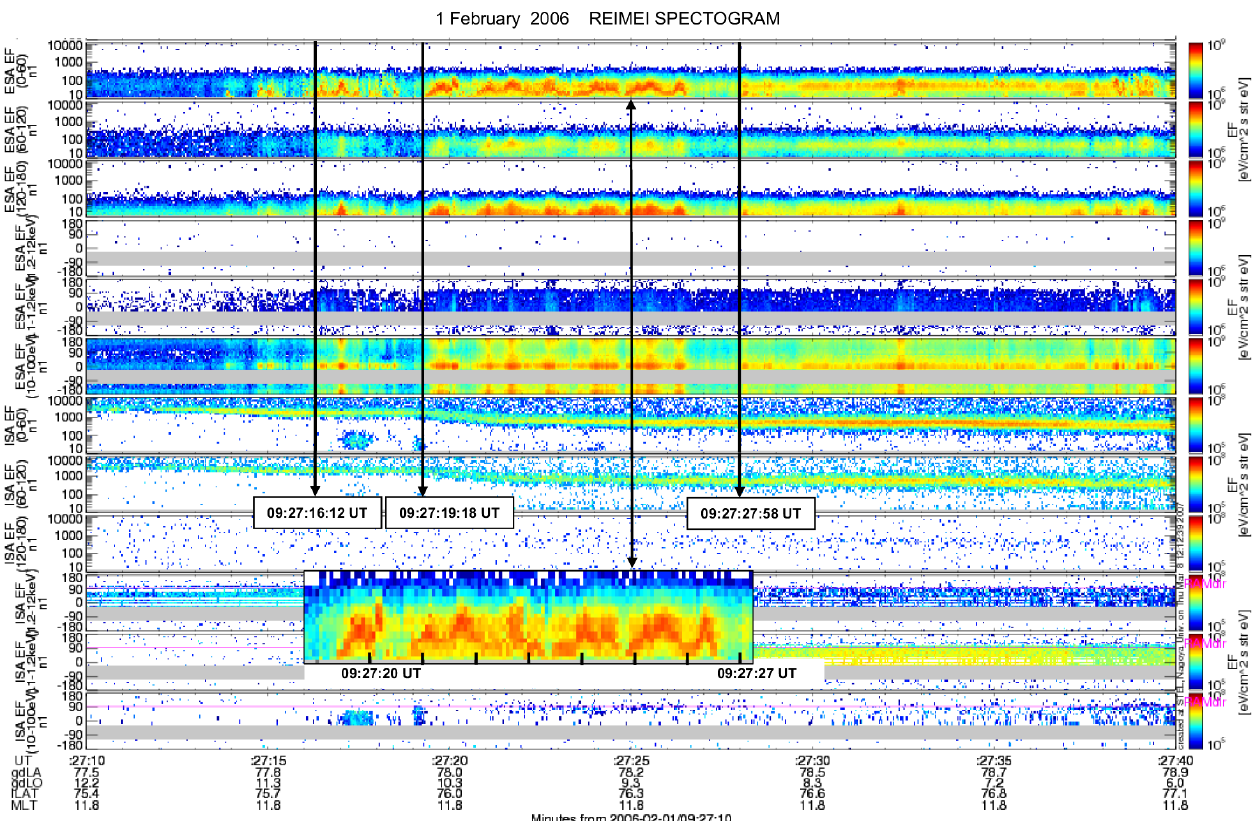
Fig. 3. High resolution electron- (panels 1–6) and ion- (panels 7–12) spectrogram: panels 1–3 and 7–9 (starting from the top) is flux and energy versus time and pitch angles (0 ◦ –60 ◦ (down), 60 ◦ –120 ◦ and 120 ◦ –180 ◦ ), panels 4–6 and 10–12 is the flux and pitch angles versus time and energy channel (10–100eV, 0.1–1.2keV, 1.2–12keV). The 3 vertical black lines represent the start of the first 3 steps in the ion- energy-dispersion, as well as the start of rapid fluctuations in the electron data (the 4th and 5th step, ∼ 09:27:41UT and ∼ 09:27:46UT, are not shown). The periods of no or almost no electron are clearly seen. The frame seen at the bottom of the figure shows an enlargement of the interval between ∼ 09:27:19UT and ∼ 09:27:27UT. The electron fluctuations start at ∼ 09:27:19:18 and end at ∼